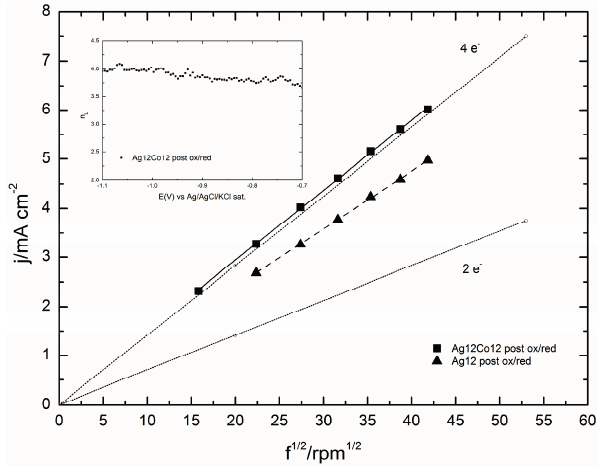
Figure 12. The Levich plot of the GC/Ag12Co12 after the oxidative/reductive treatment and the GC/Ag12 sample after the same treatment at E = − 1.1V is reported. Inset: the average number of electrons exchanged during the ORR and extrapolated from the Levich plot of the GC/Ag12Co12 sample is reported in the potential range − 0.8– − 1.1